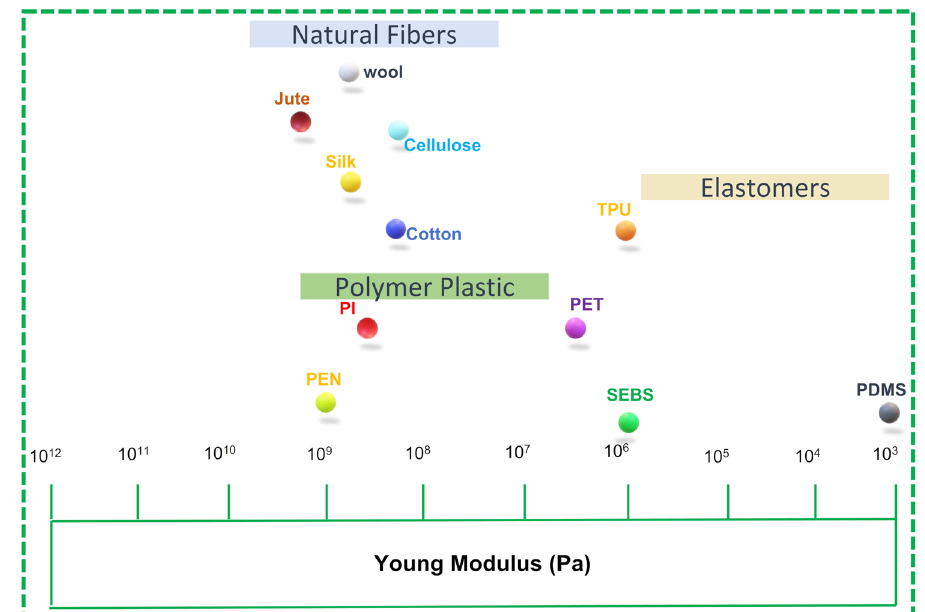
Fig. 3 Young’s Modulus of materials for flexible and wearable electronics [34,